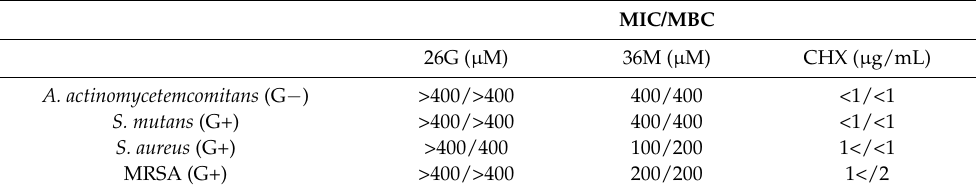
Table 1. MIC and MBC of 26G and 36M for the oral microbes.